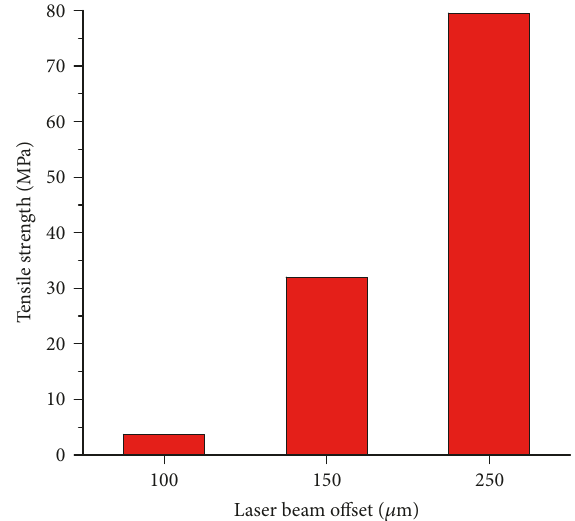
Figure 26: The dependence of tensile strength of joints on the laser offset (laser power of 800